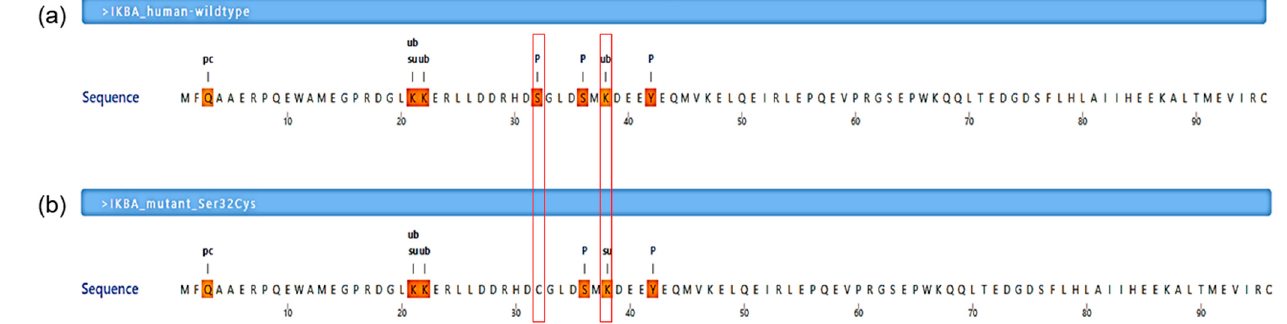
* Phosphorylation loss is predicted if the joint probability p > 0.5.